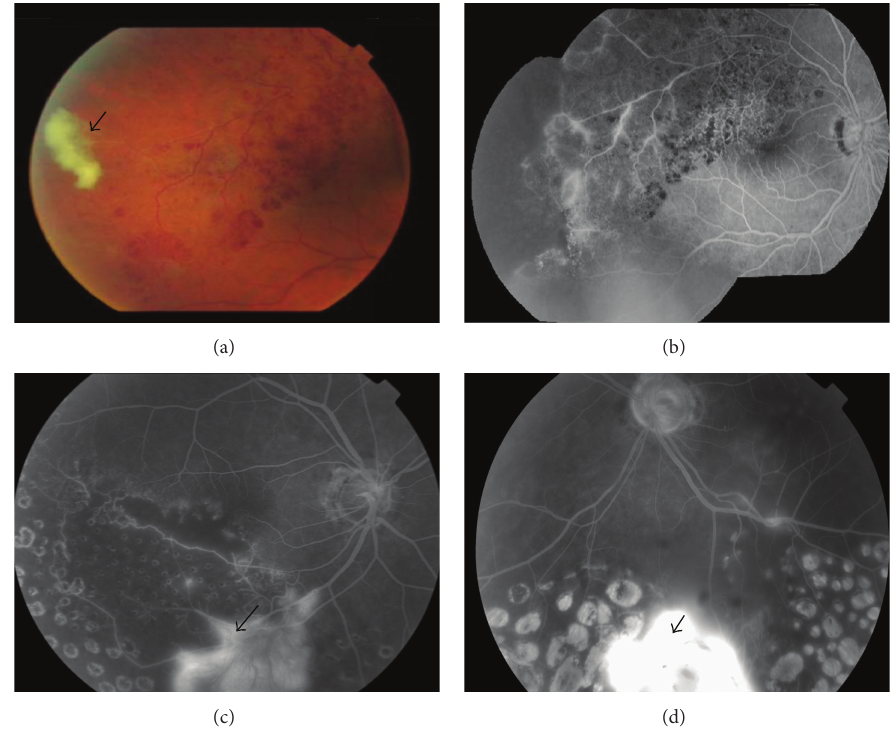
Figure 5: Fundus images show vasooclusion in patients with positive anticardiolipin antibodies. (a) Color image showing peripheral branch retinal vein occlusion with an intraretinal haemorrhage and peripheral fibrovascular tuft (Arrow). (b) Fluorescein angiography of the same patient showing vascular fluorescein leakage together with peripheral retinal nonperfusion. (c, d) Fluorescein angiography of another patient demonstrating bilateral retinal ischemia with areas of hypoperfusion covered with laser photocoagulation scars. There are also bilateral fibrovascular tufts leaking fluorescein